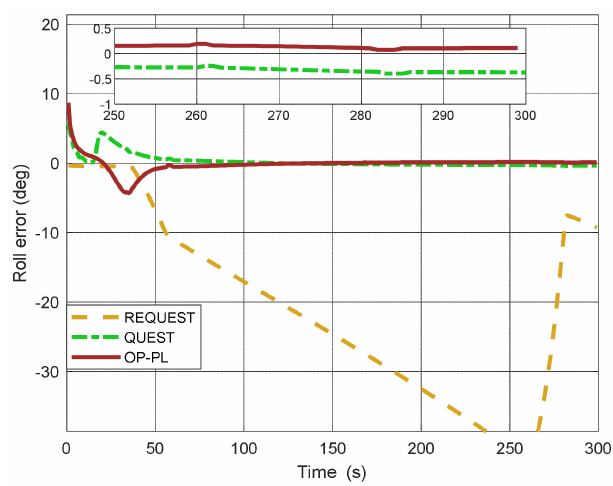
Figure 9. Curves of roll angle errors.